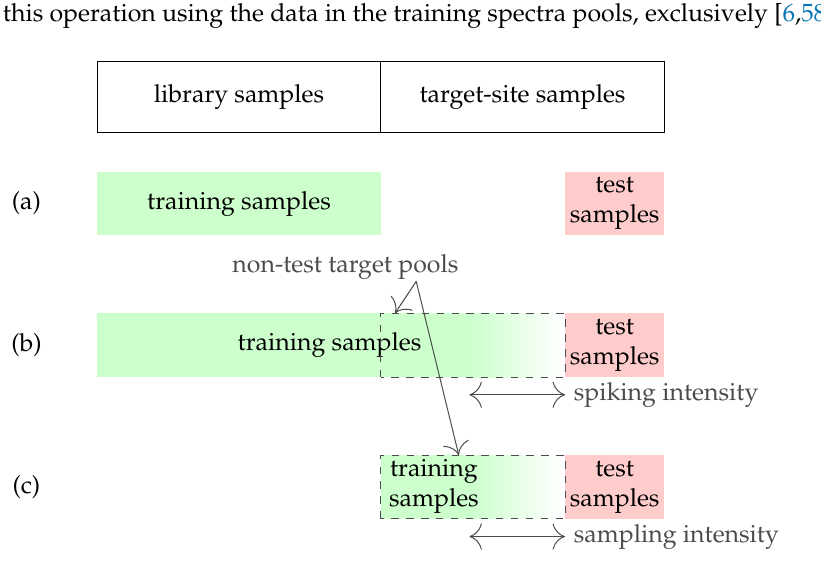
Figure 3. The possibilities of data subsetting compared in the study: ( a ) Library-only partitioning without calibration spiking. ( b ) The library data are augmented with target samples from a training pool, the number of which is given by the spiking intensity. ( c ) Local-only models trained exclusively to target-site samples, the number of which is given by the sampling